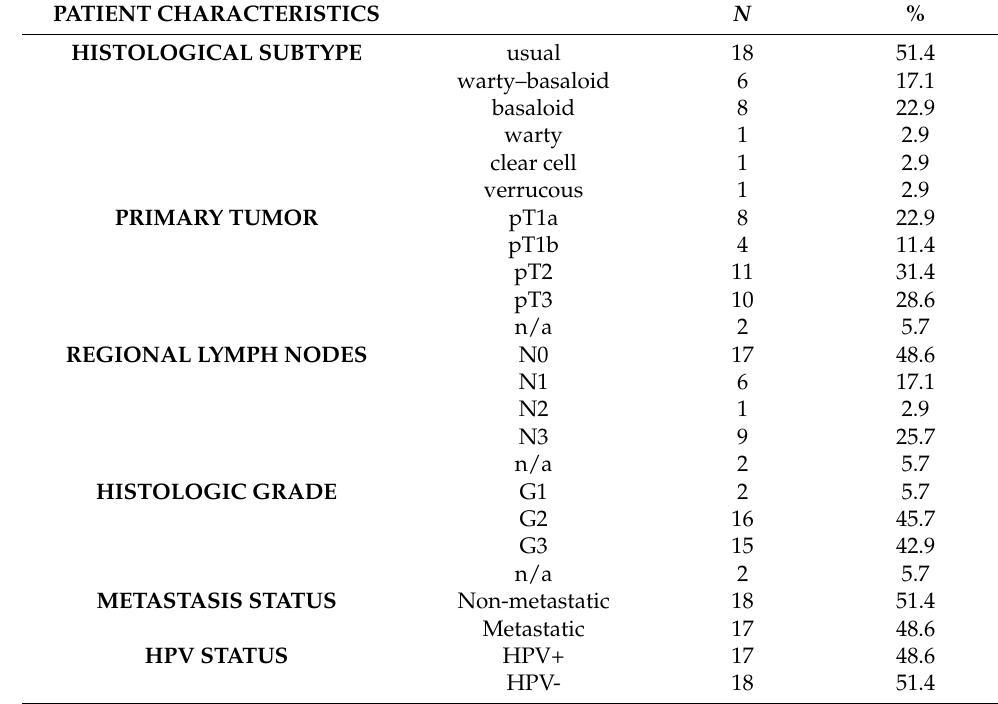
Table 1. Summary of the clinical and histopathological data of the penile squamous cell carcinoma (PSCC) samples. n/a: Not available. In addition to lymph node metastases, visceral metastases were found in liver and lung. HPV: Human